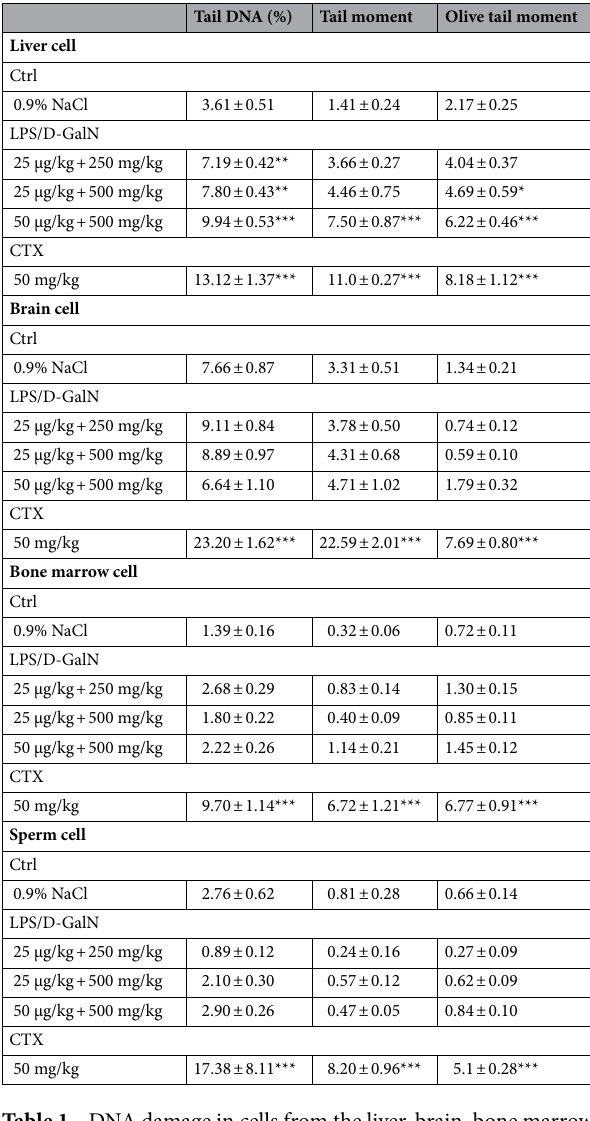
Table 1. DNA damage in cells from the liver, brain, bone marrow and testes (sperm) extracted from mice acutely administered with LPS/D-GalN. Mice were injected with LPS/D-GalN (25 μg/kg + 250 mg/kg, 25 μg/ kg + 500 mg/kg and 50 μg/kg + 500 mg/kg body weight), and after 6 h mice were sacrificed and tissue samples collected for subsequent examination. Saline solution (0.9%) and cyclophosphamide (CTX) (50 mg/kg body weight) were used as negative and positive control, respectively. SCGE assay was performed using cells from each tissue. Data are expressed as means ± S.D.; * P < 0.05, ** P < 0.01 and *** P < 0.001, compared with from the control